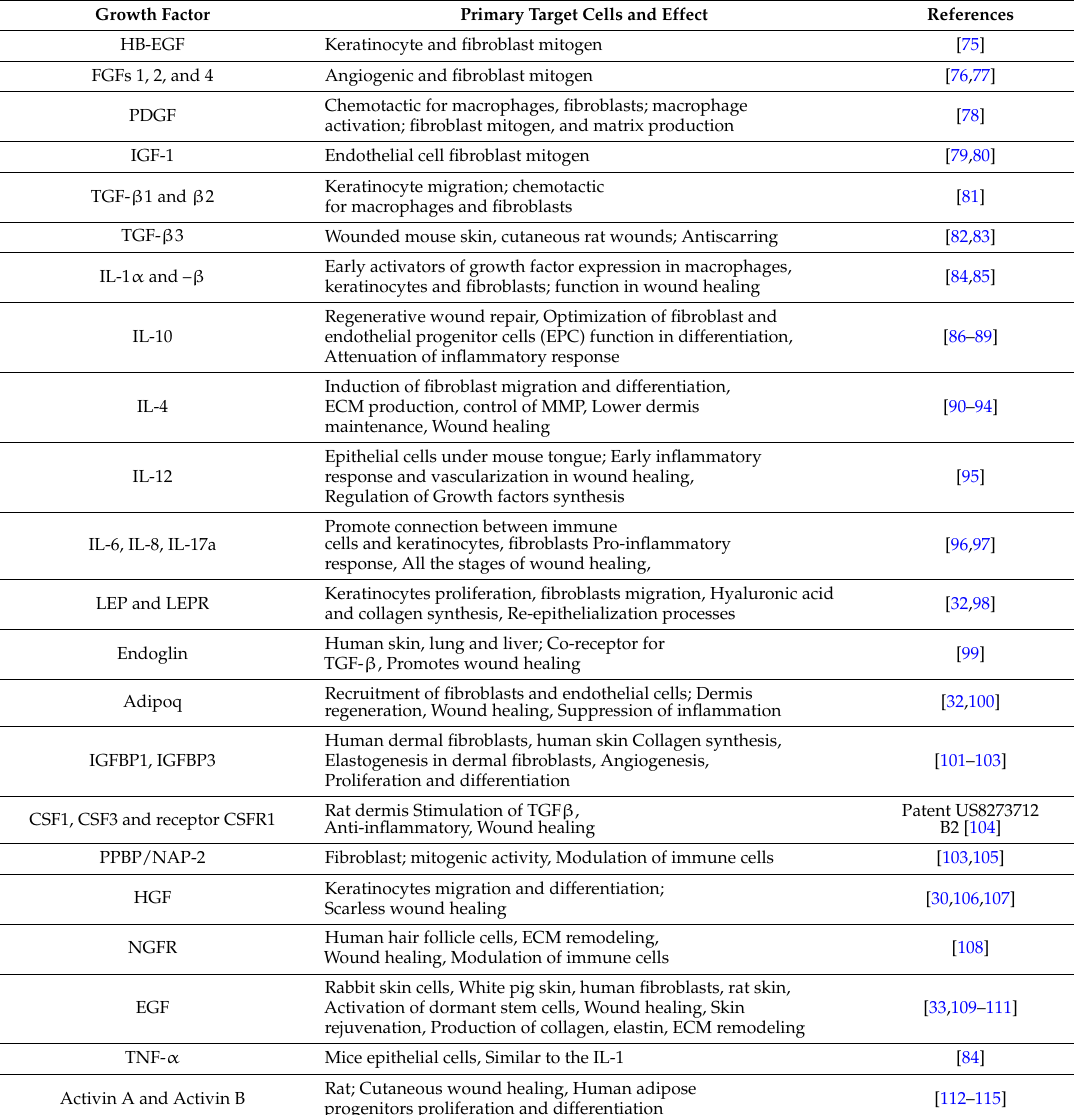
Table 1. Growth factors and their function in skin homeostasis, regeneration and repair. Growth